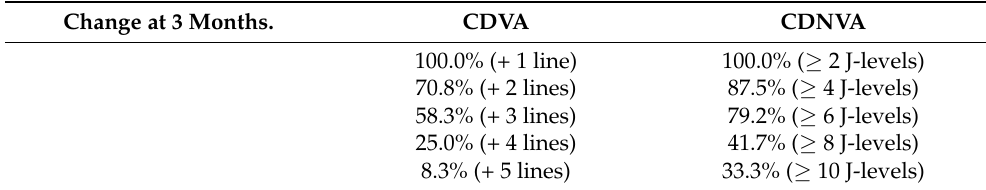
CDVA = best-corrected distance visual acuity; CDNVA = best-corrected near visual acuity; J = Jaeger.